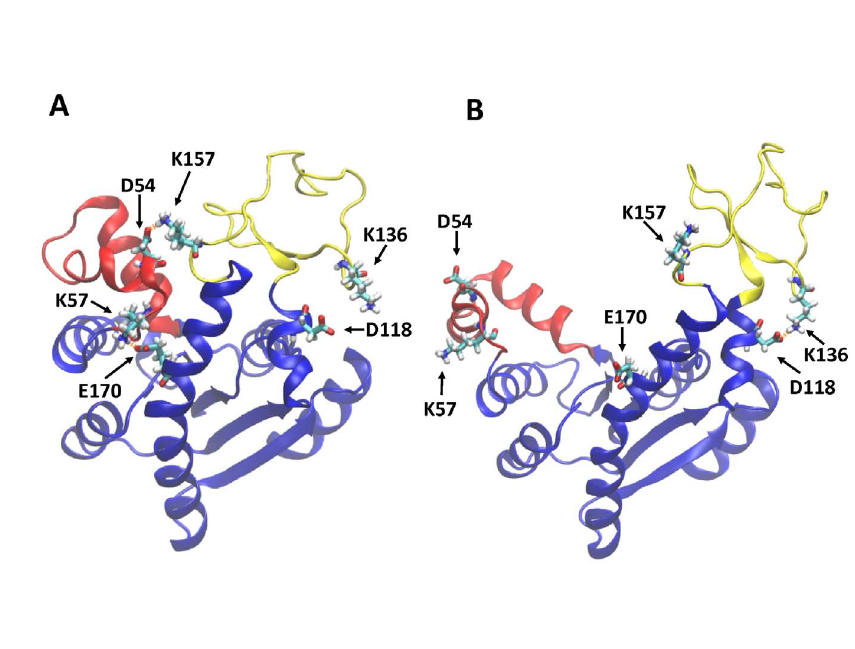
Figure 4. Some typical salt bridges in the closed (A) and open (B) AdK conformations. The two snapshots were taken from simulations C5 and O1, respectively. The images were rendered using the VMD software [45].